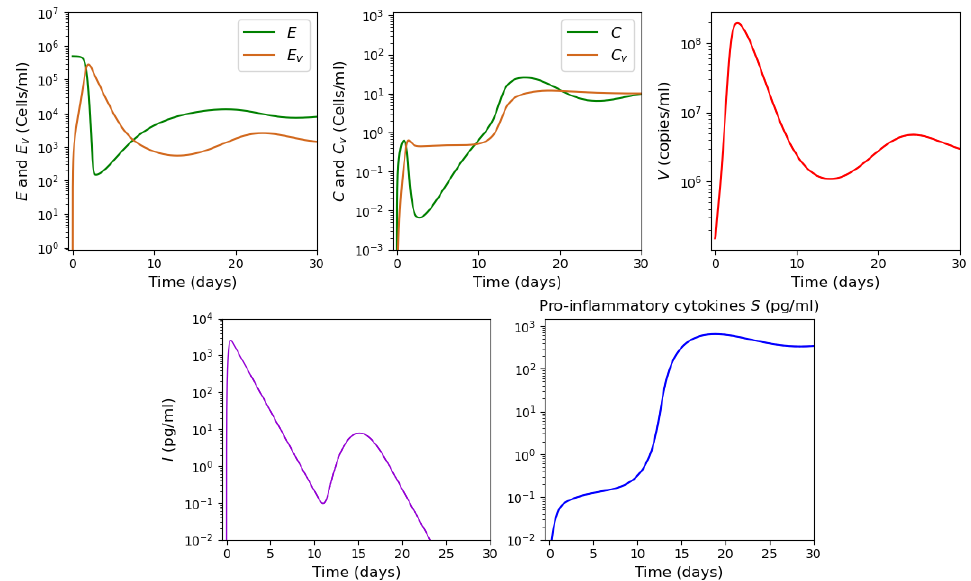
Figure 12. Numerical simulation for system (22)–(28). The values of parameters for the numerical experiment are detailed in Appendix A Tables A1 and A3. The initial conditions correspond to those listed in Appendix A Table